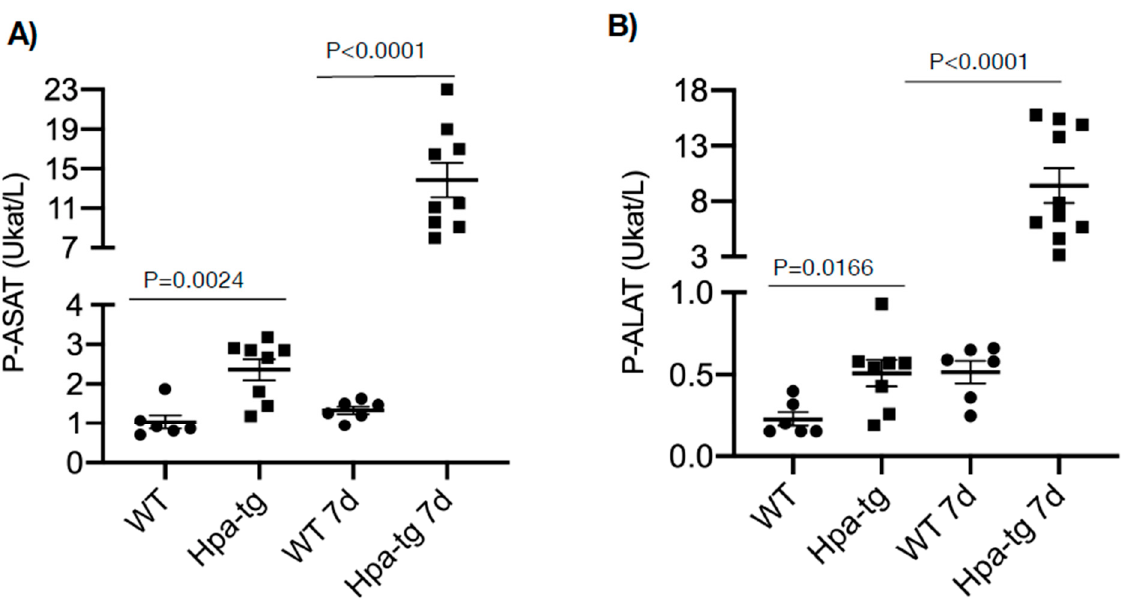
Figure 1. Plasma was collected from naïve and CCL4-treated mice and analyzed for p-ASAT ( A ) and p-ALAT ( B ) levels at the clinical biochemical laboratory, Akademiska hospital, Uppsala University. Higher levels of both enzymes were noted in naïve Hpa-tg vs. WT mice and even more so in CCL4-treated Hpa-tg vs. WT mice. ( n = 6–10).